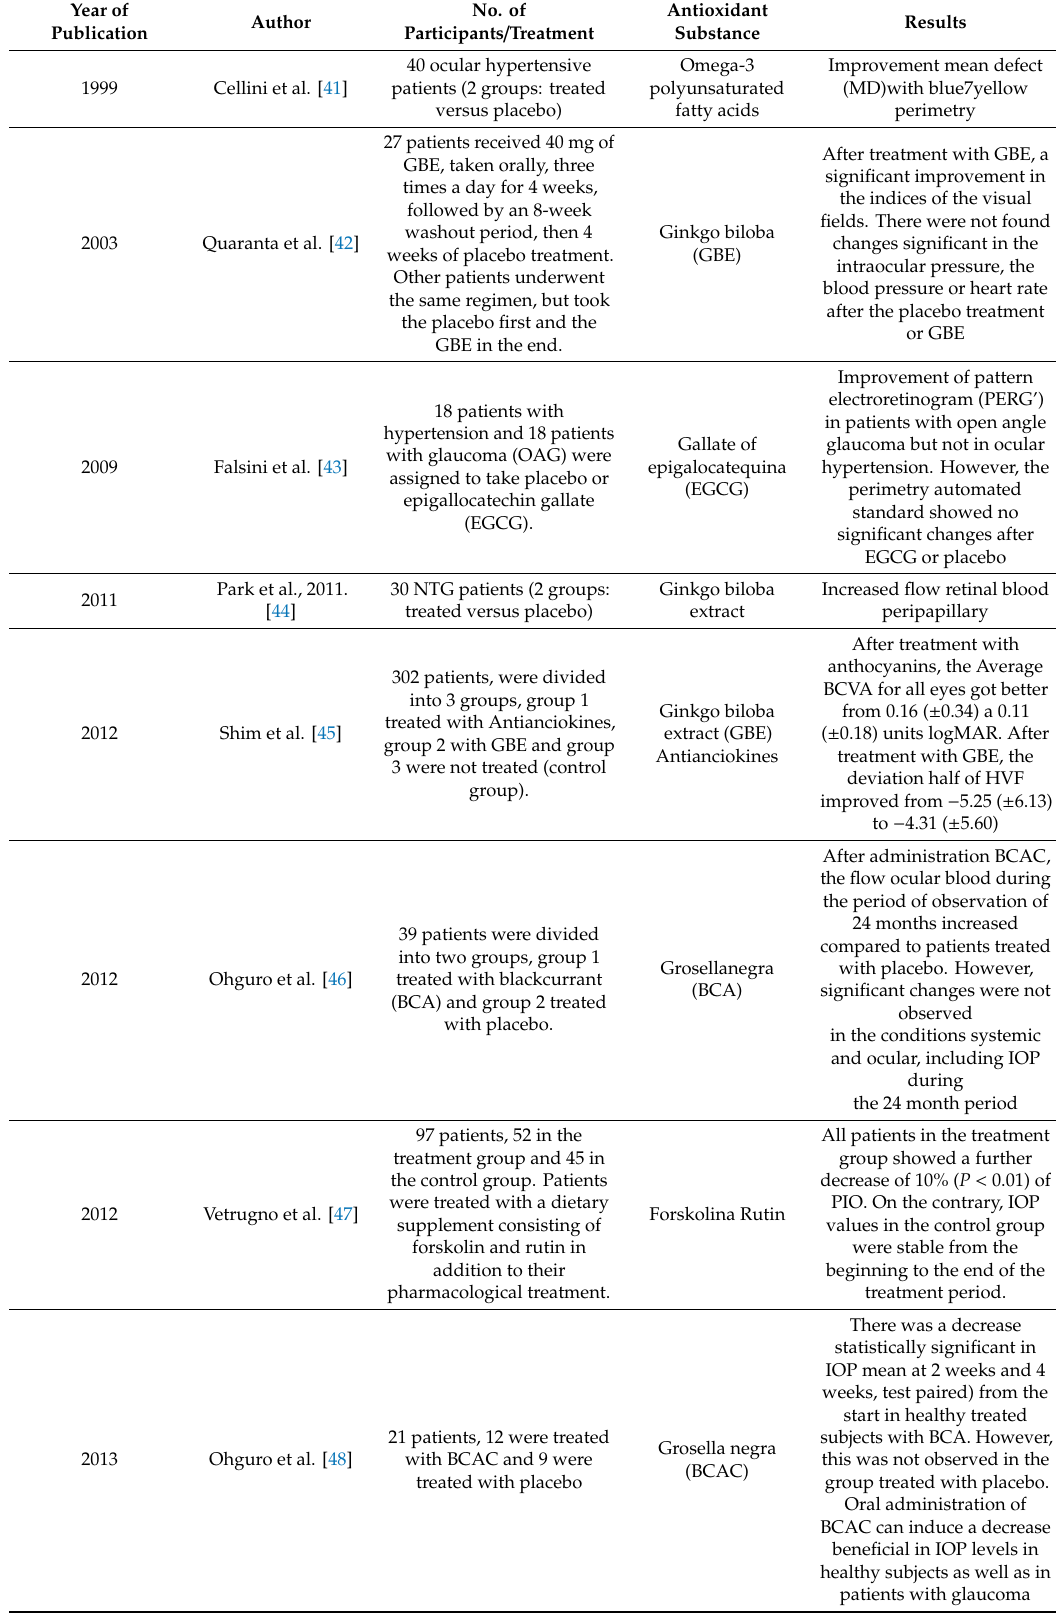
Table 2. Summary of antioxidant supplementation in clinical trials (chronological